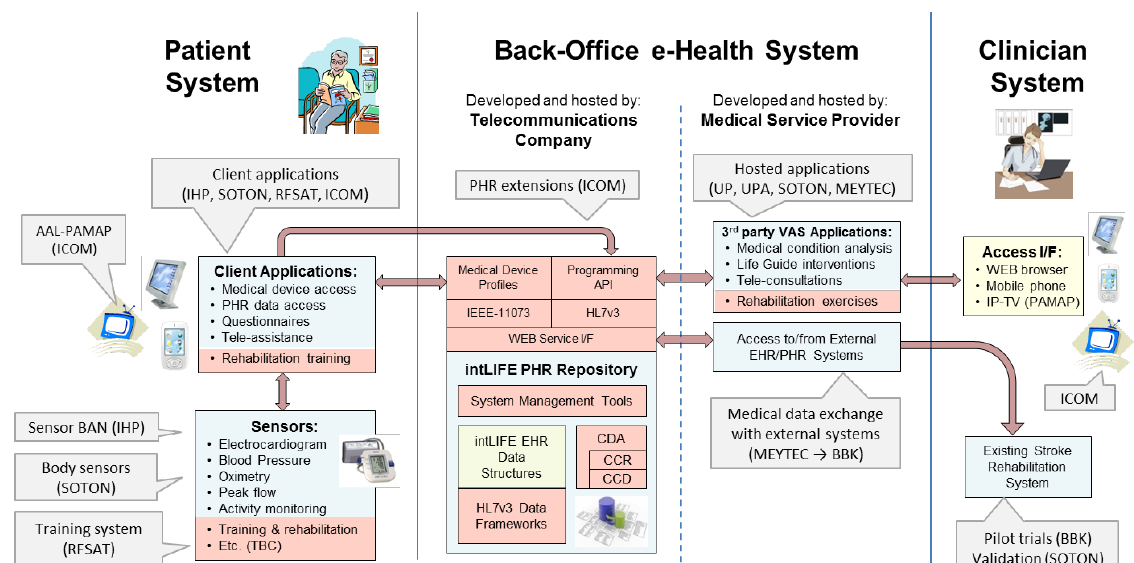
Figure 1 . Concept architecture of StrokeBack